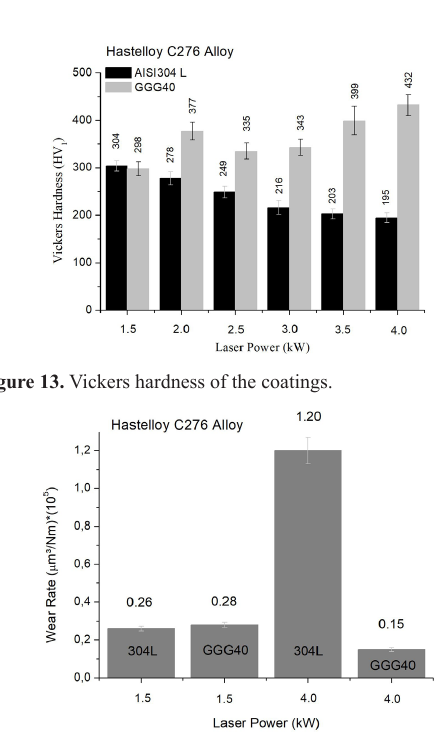
Figure 14. Wear rate of coatings versus laser power.